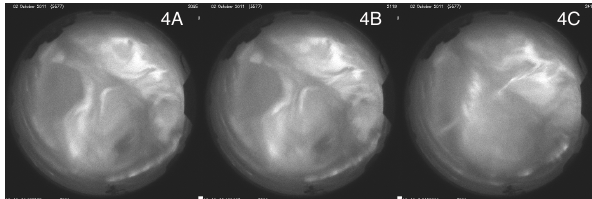
Figure 15. Event 4: narrow-field images (15 ◦ FOV) – taken on 2 October 2011 with a 427.8nm filter – showing the small-scale structure of the aurora at the times of the NEIALs in the PFISR data (labeled 4A–4C). The magnetic zenith – the location of the radar beam ( ∼ 1 ◦ beamwidth) – is located near the center of each image. Same orientation as Fig.